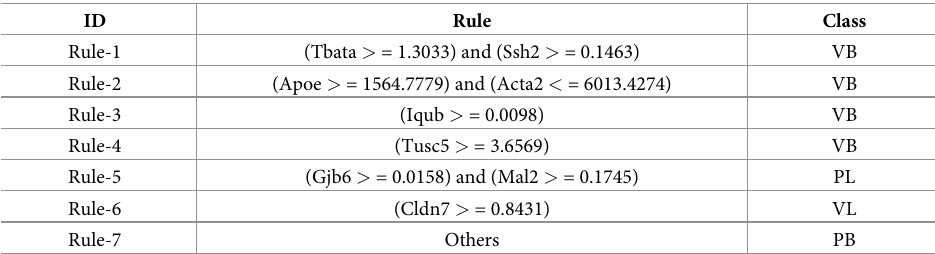
Table 2. Rules generated by